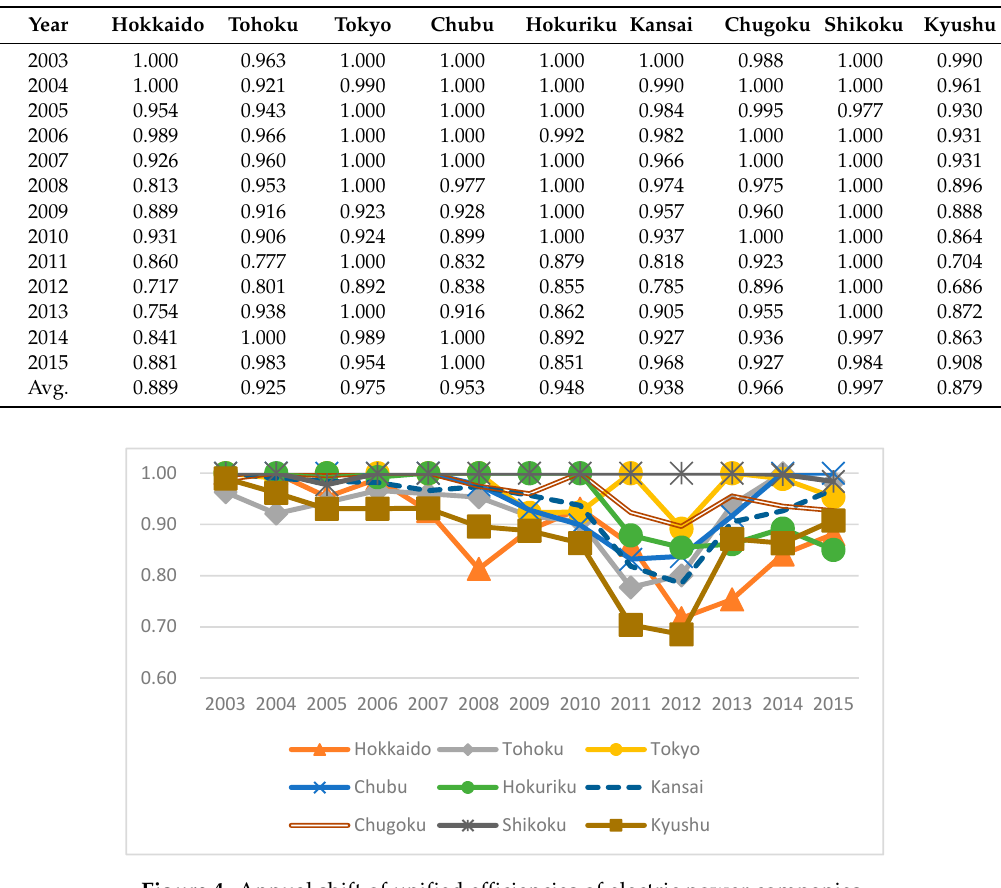
Figure 4. Annual shift of unified efficiencies of electric power companies.